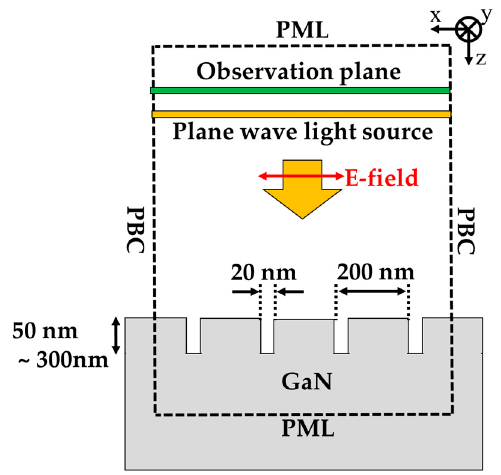
Figure 5. Two dimensional- finite-dereference time-domain (FDTD) calculation model of the GaN-HCG.